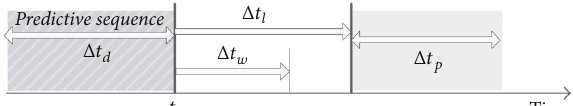
Figure 2: Prediction mechanism of upcoming social unrest events. 𝑡 : present time ; Δ𝑡 Δ𝑡 Δ𝑡 𝑙 : lead time ; 𝑤 : warning time ; 𝑝 : prediction period ; Δ𝑡 𝑑 : data window size